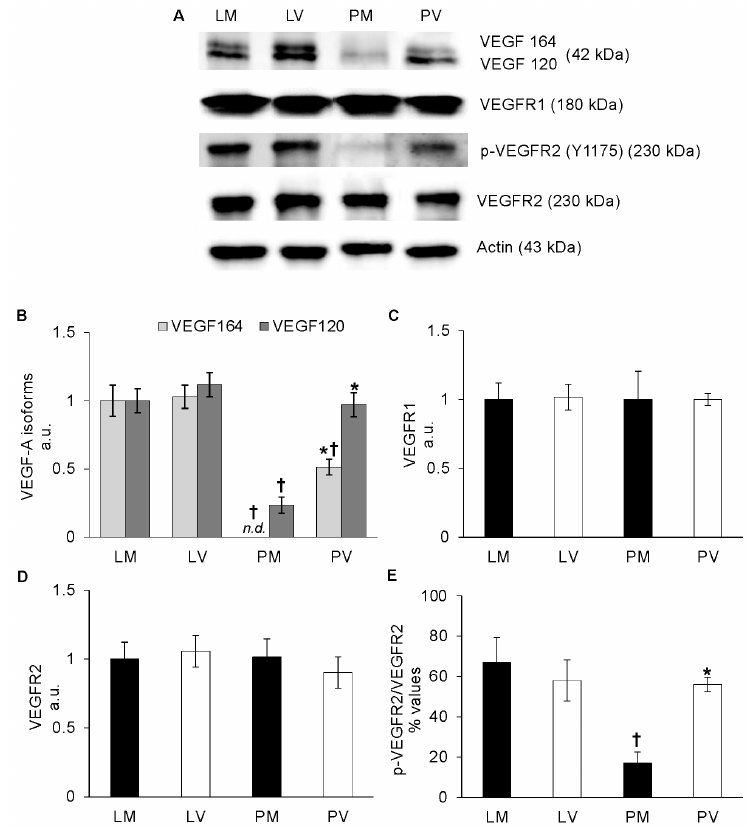
Figure 1. VEGF-A and VEGFRs protein content in whole mice ovaries. Representative western blot images of VEGF-A isoforms (VEGF 164 and VEGF 120), VEGFR1, and VEGFR2 total and